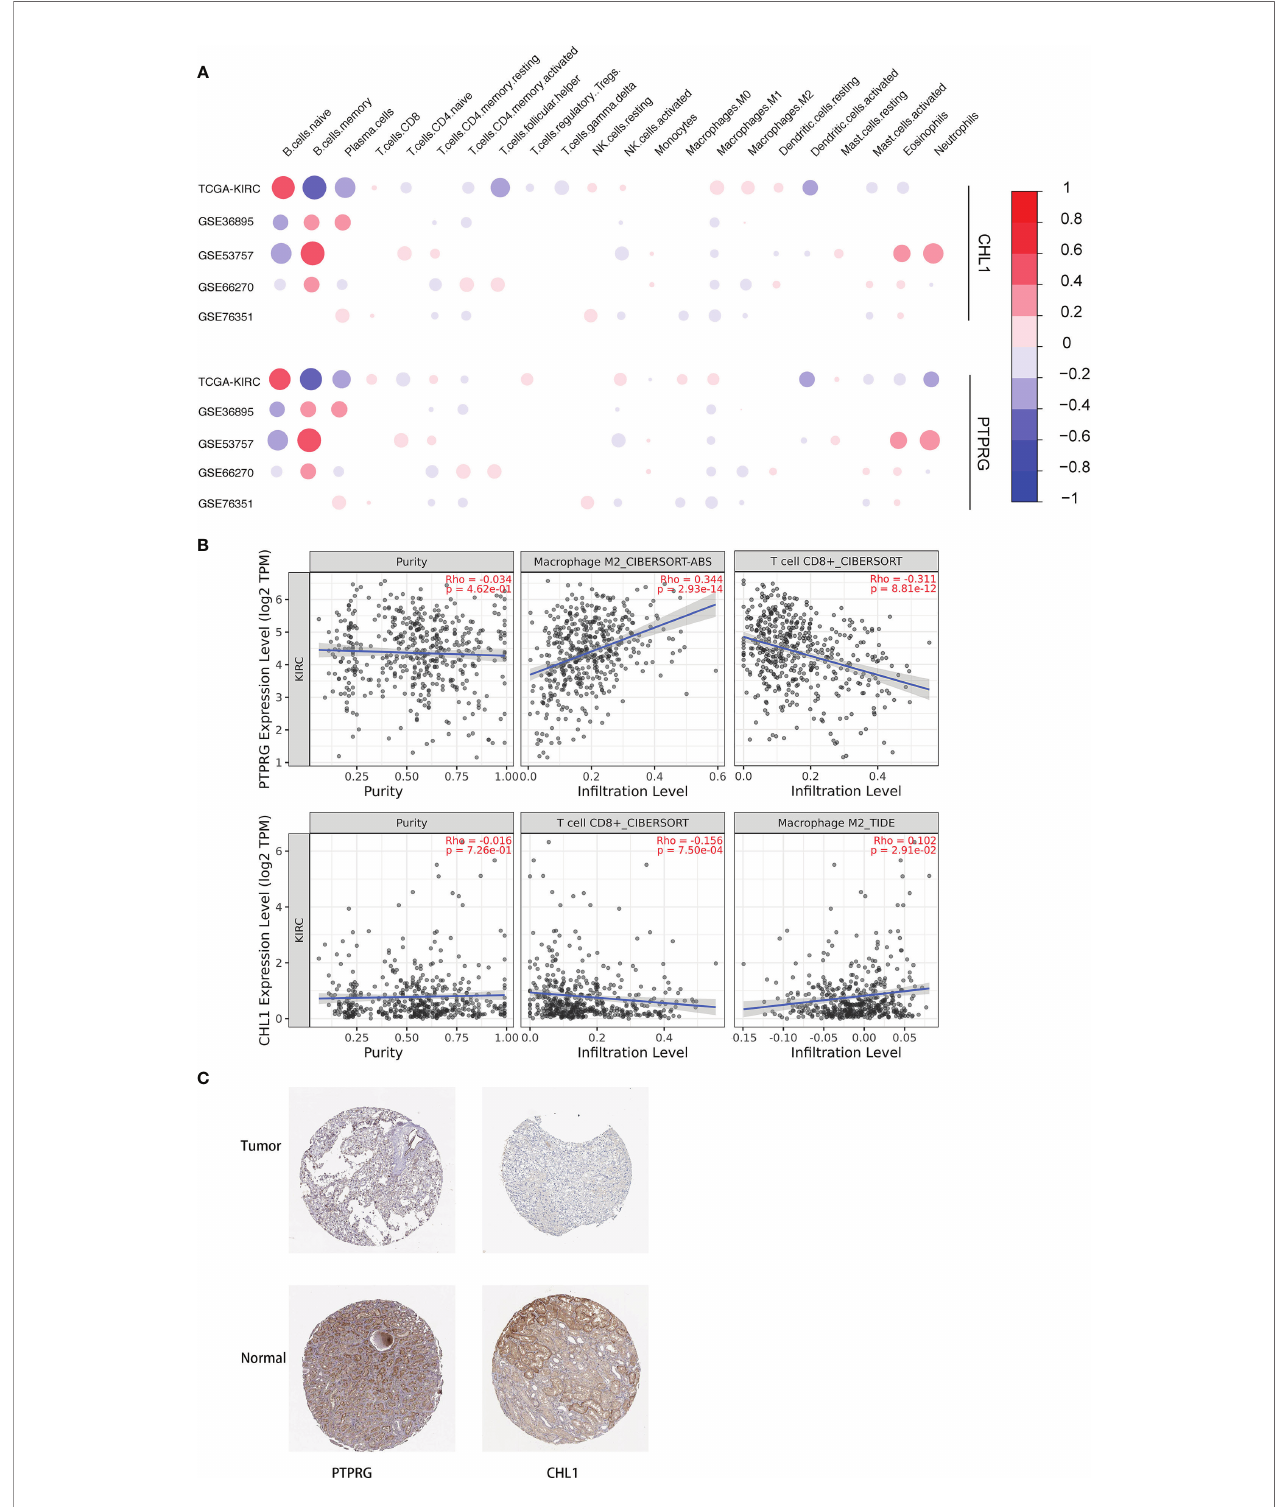
FIGURE 12 | (A) Correlation between 22 immune cells relative contents and expression levels of PTPRG and CHL1. The abscissa indicates 22 kinds immune cells while the ordinate represents 5 independent datasets of KIRC. Red means positively related; blue means negatively related; size of circles and shades of colors mean magnitude of correlation. (B) Correlation between mRNA levels of PTPRG/CHL1 and relative contents of Macrophage M2 cells and CD8 + T cells with online tool TIMER 2.0. (C) Immunohistochemical results of PTPRG and CHL1 based on the Human Protein Atlas